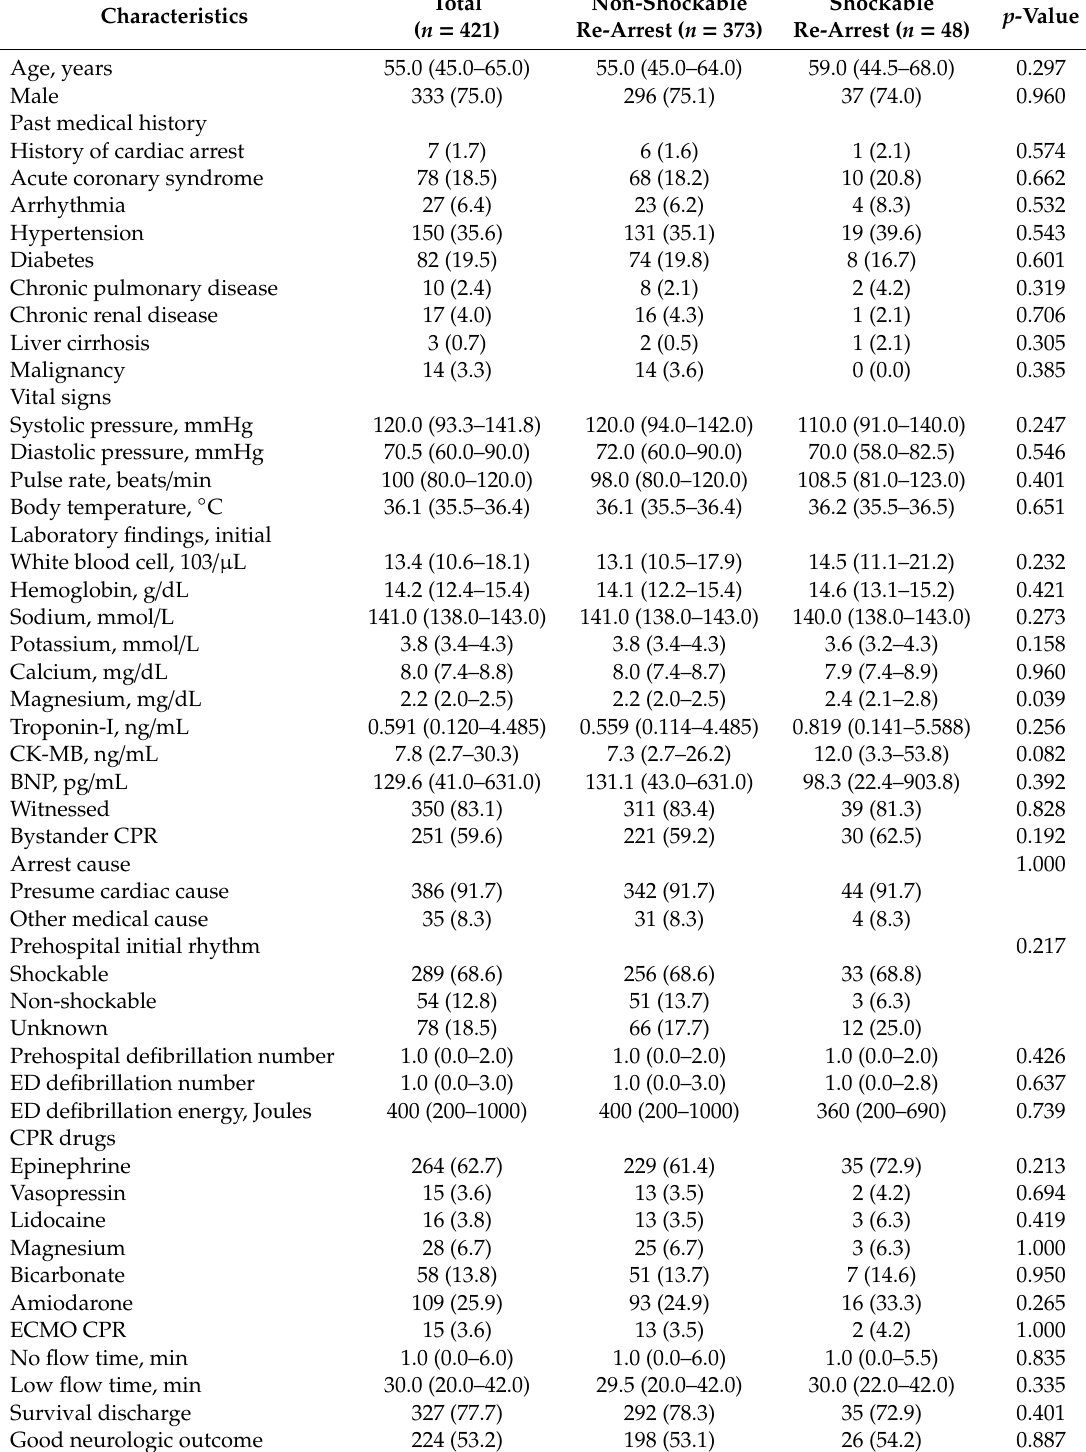
Table 2. Baseline characteristics and cardiopulmonary resuscitation profiles between patients with non-shockable re-arrest and shockable